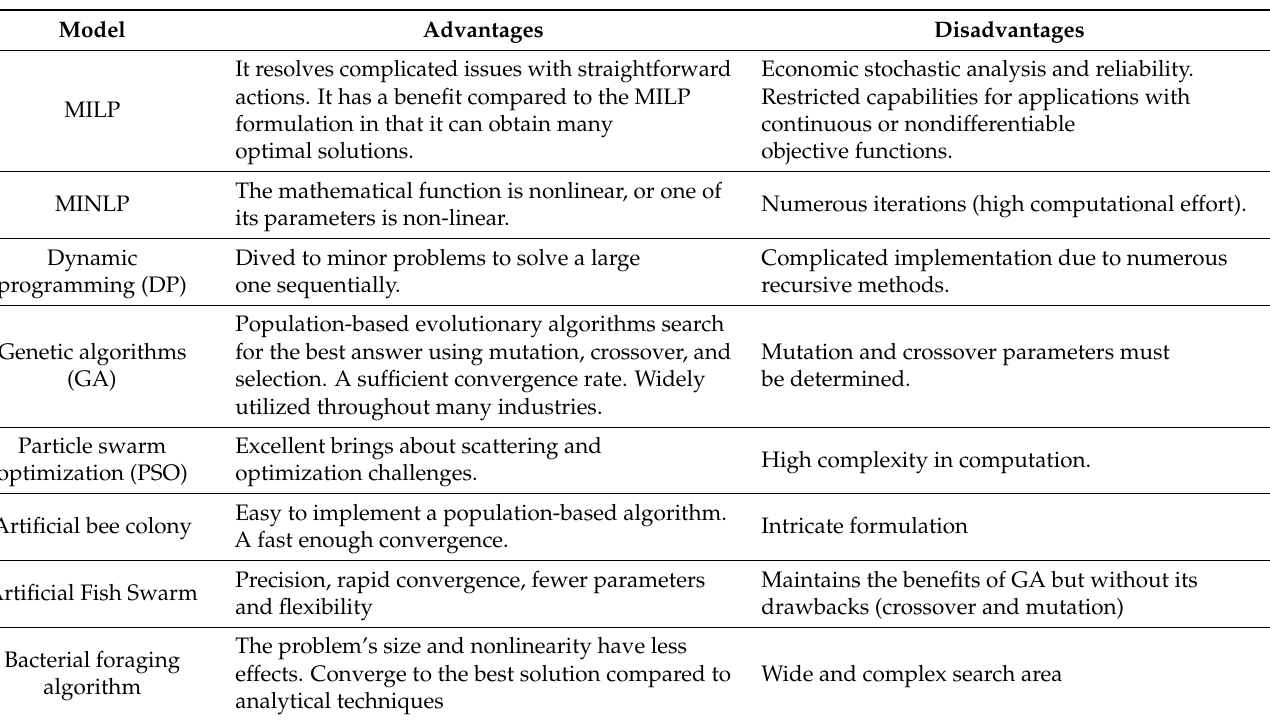
Table 1. Comparison of the optimization models.